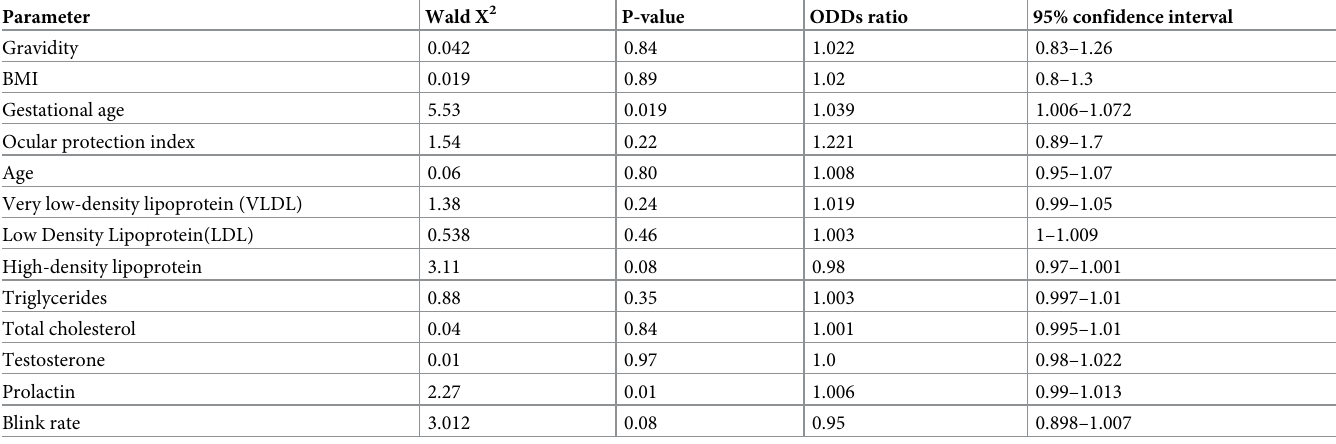
Table 2. Univariate binary logistic regression